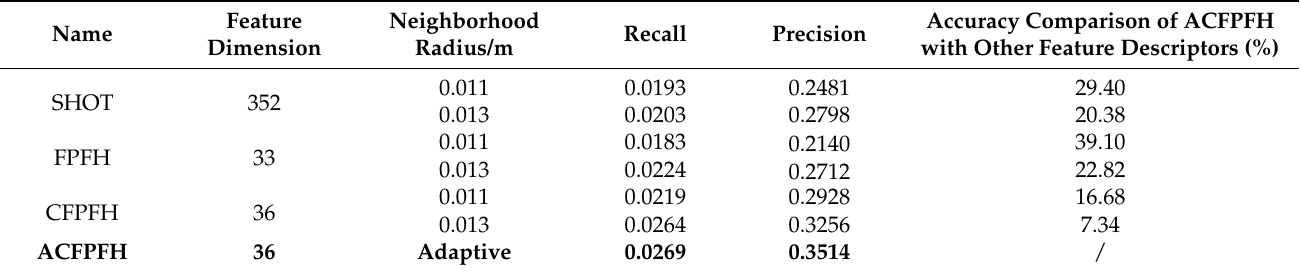
Table 2. Precision and recall comparison of different feature descriptors.